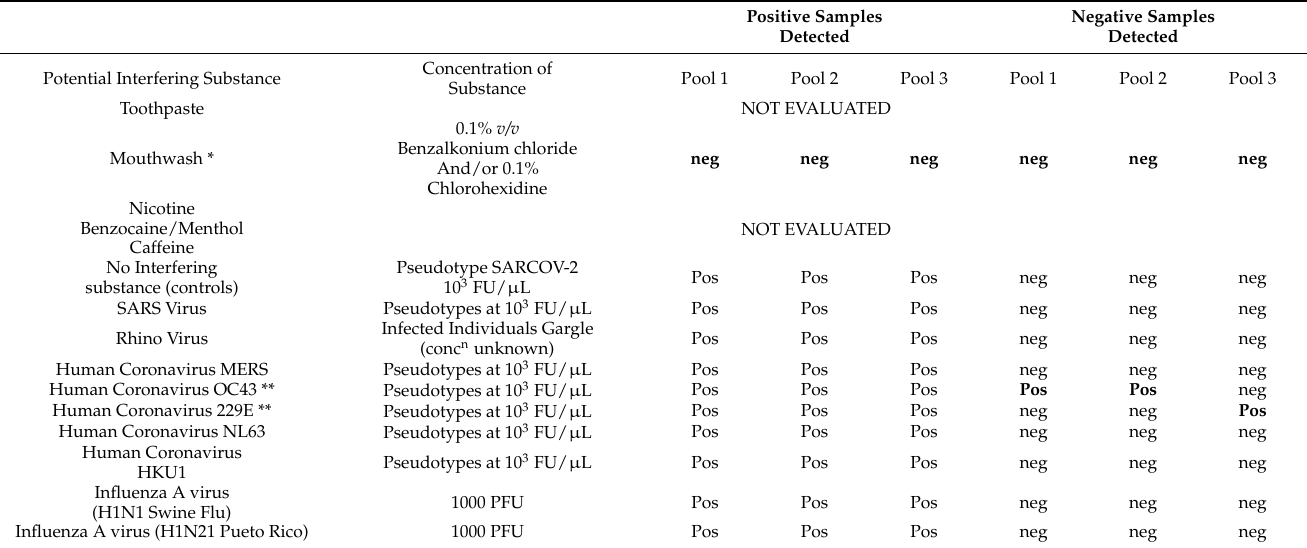
Table 2. Determination of interfering substance and cross reaction with other viruses in the MALDI– ToF MS test for SARS-CoV-2.